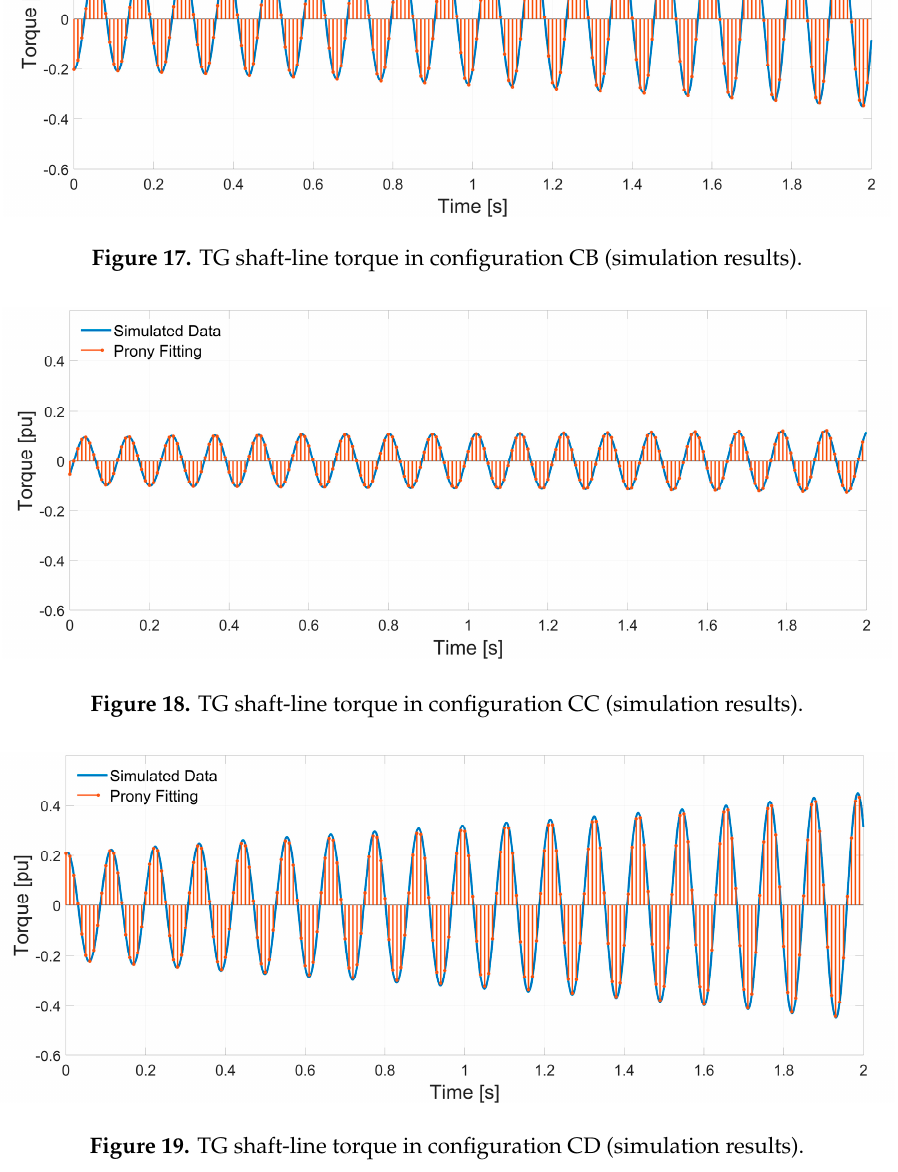
Figure 19. TG shaft-line torque in configuration CD (simulation results).